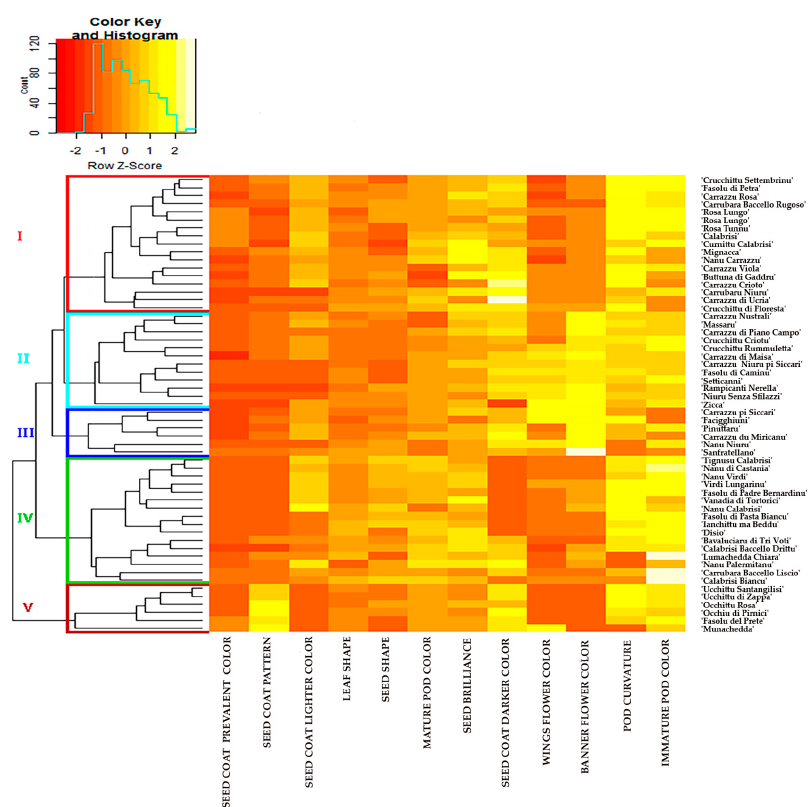
Figure 5. Heatmap of seed, pod and flower morphological traits of 57 Sicilian common bean accessions based on Euclidean distances. Red and yellow colors represent reduced and augmented representation levels, respectively. Hierarchical clustering of accessions (from cluster I to V) and traits are also shown.